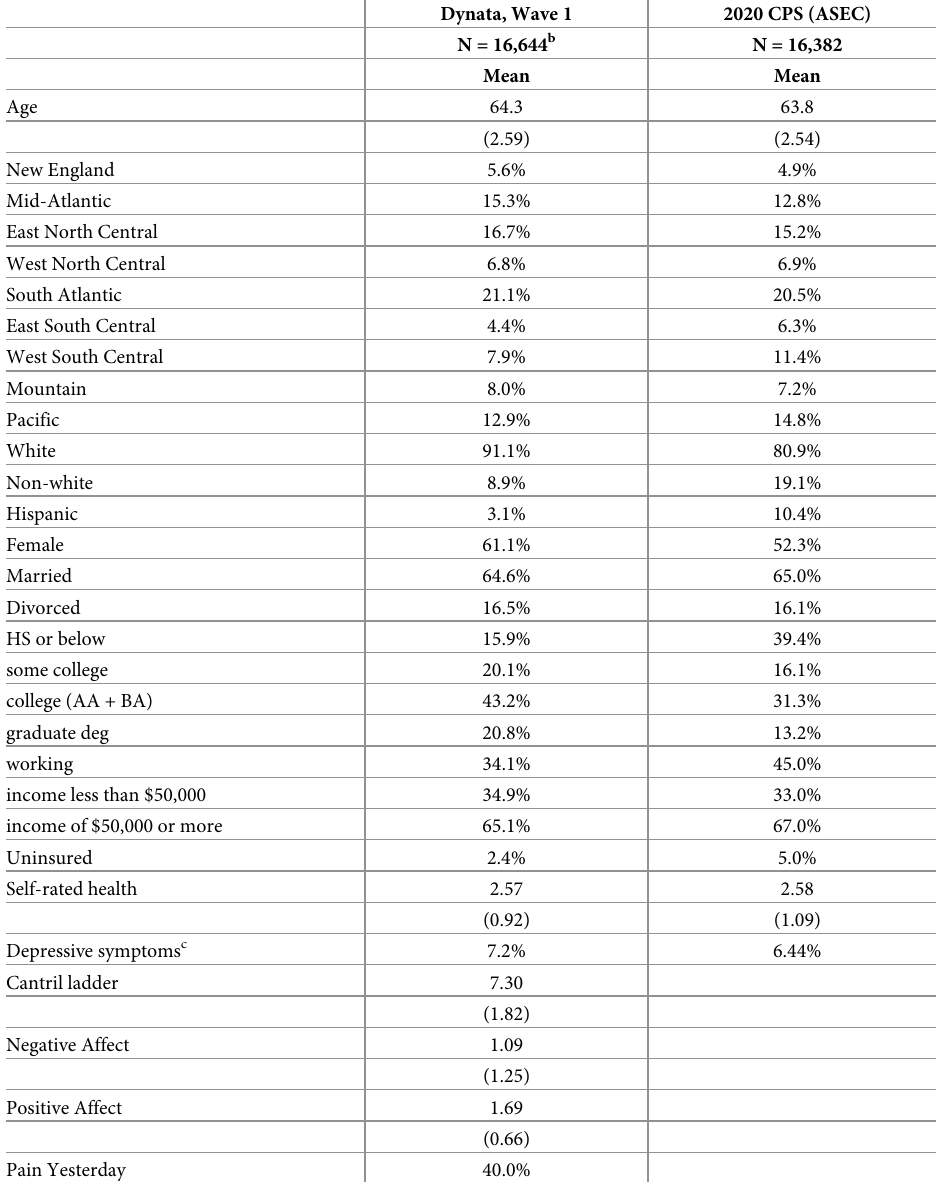
Table 1. Wave 1 Dynata sample characteristics a and comparison with the